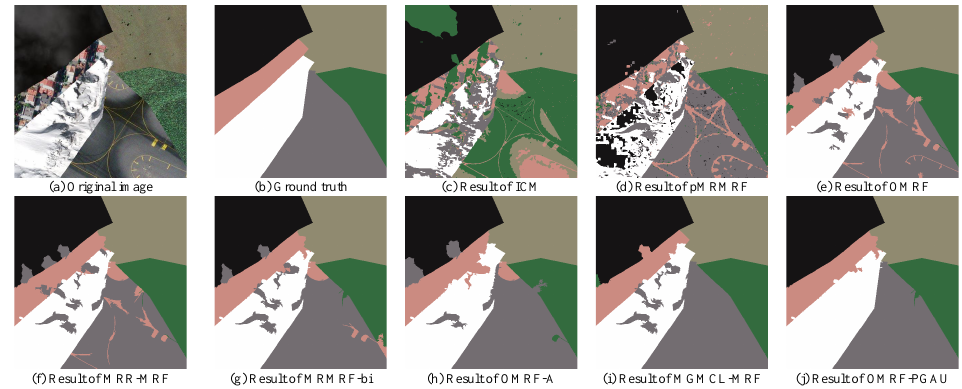
Figure 7. Semantic segmentation results for GeoEye texture